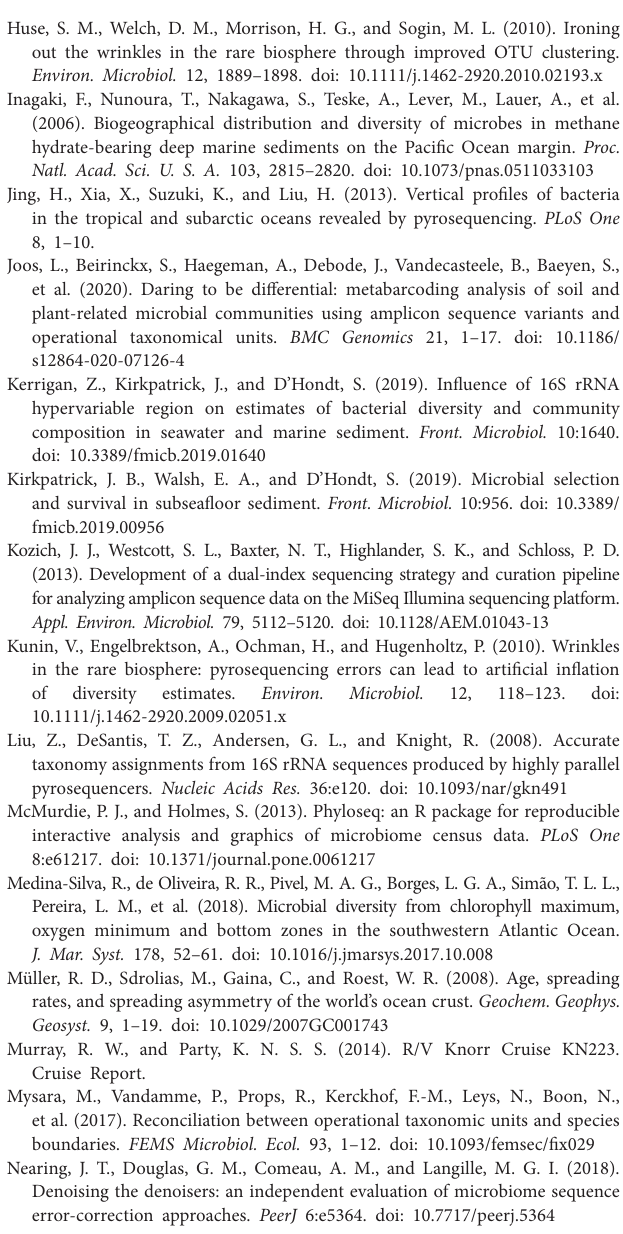
Supplementary Table S1 | Water-column samples. Supplementary Table S2 | Sediment